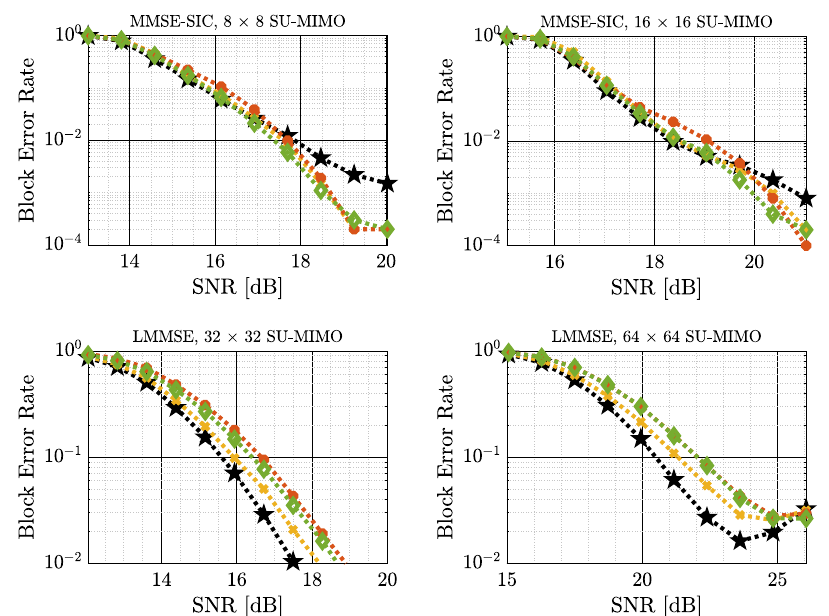
Fig. 10 Quantization performance of EQ-Net evaluated against state-of-the-art methods in large and very large MIMO, 16-QAM, i.i.d. Rayleigh fading, and LDPC-coded with size (324, 648). a 8 × 8 MIMO, using MMSE-SIC soft bits for training and testing. b 16 × 16 MIMO, using MMSE-SIC soft bits for training and testing. c 32 × 32 MIMO, using MMSE-SIC soft bits for training and LMMSE soft bits for testing. d 64 × 64 MIMO, using MMSE-SIC soft bits for training and LMMSE soft bits for